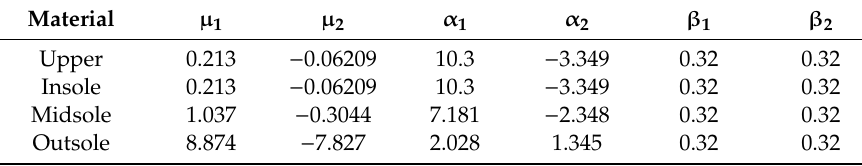
Table 1. The parameters of the Ogden foam material model used for footwear materials.